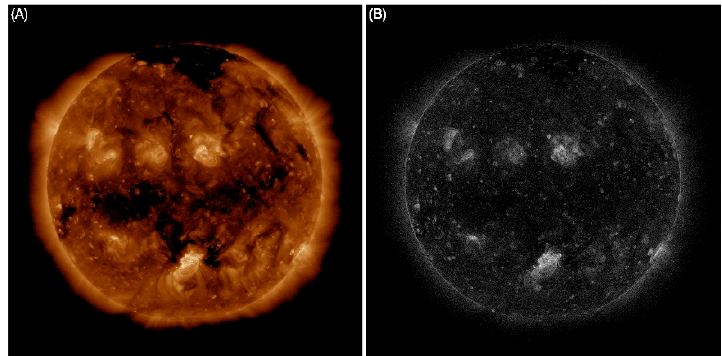
Figure 2. The original solar image ( A ) and the image calculated by Sobel operator ( B ).